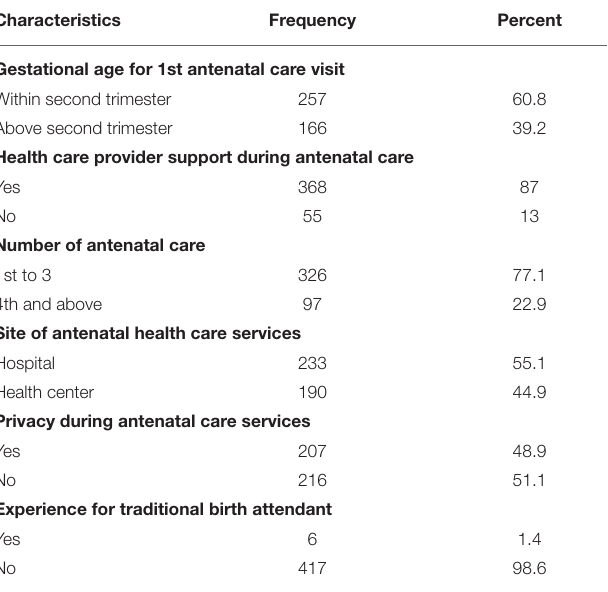
TABLE 4 | Maternal health care service-related factors of pregnant women in Debremarkos city, northwest Ethiopia.